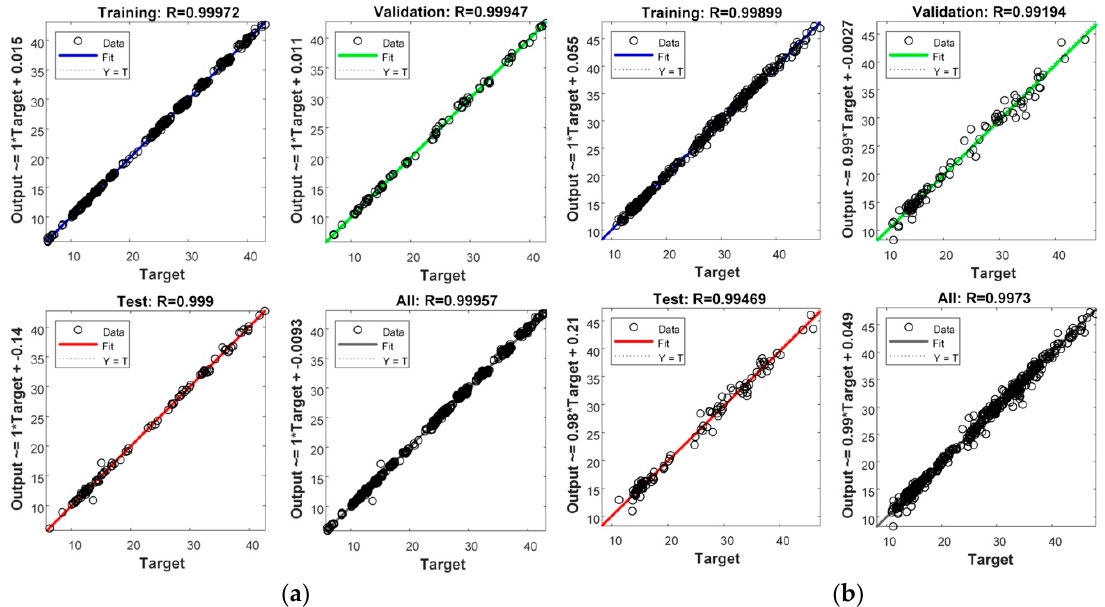
Figure 3. Correlation coefficient between the real value and the output of the MLP: ( a ) heating load; ( b ) cooling load.